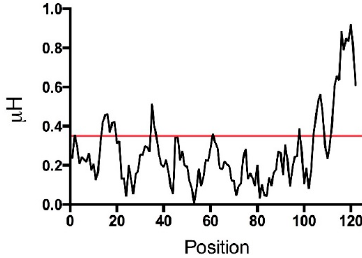
Figure 4. Plot of hydrophobic moment ( μ H) for the mature lfTSLP (131 amino acids).